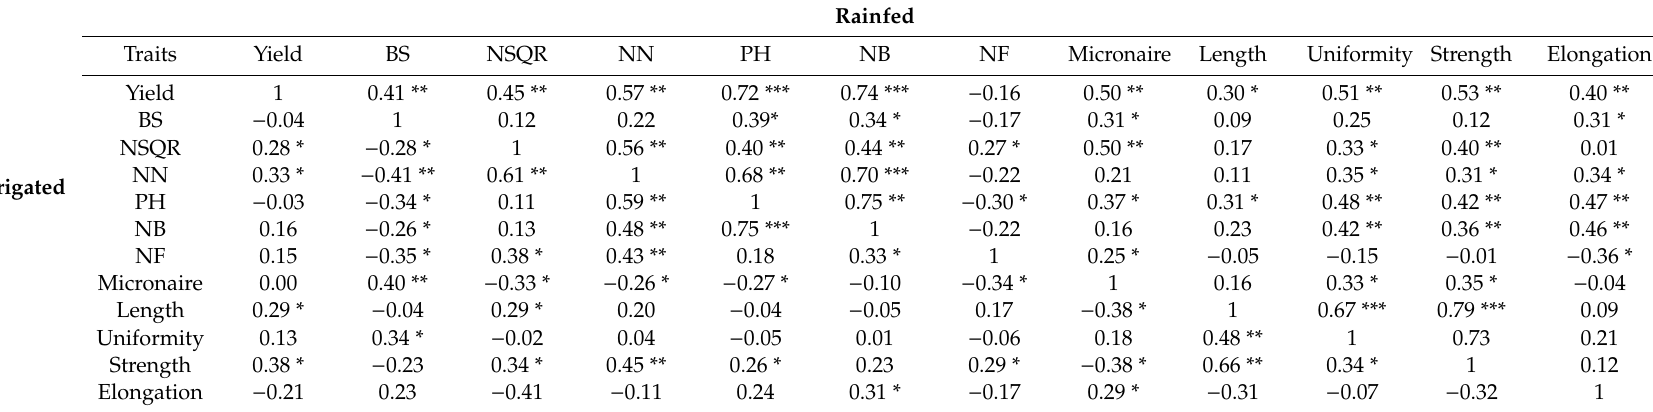
Table 4. Pearson’s correlation coe ffi cient (r) showing the relationship between yield, agronomic traits and selected fiber properties of upland cotton lines grown under irrigated and rainfed conditions. Note: the upper half of the correlation table shows the relationship between di ff erent traits in rainfed trial, while the lower half of the correlation table shows the relationship between di ff erent traits in irrigated